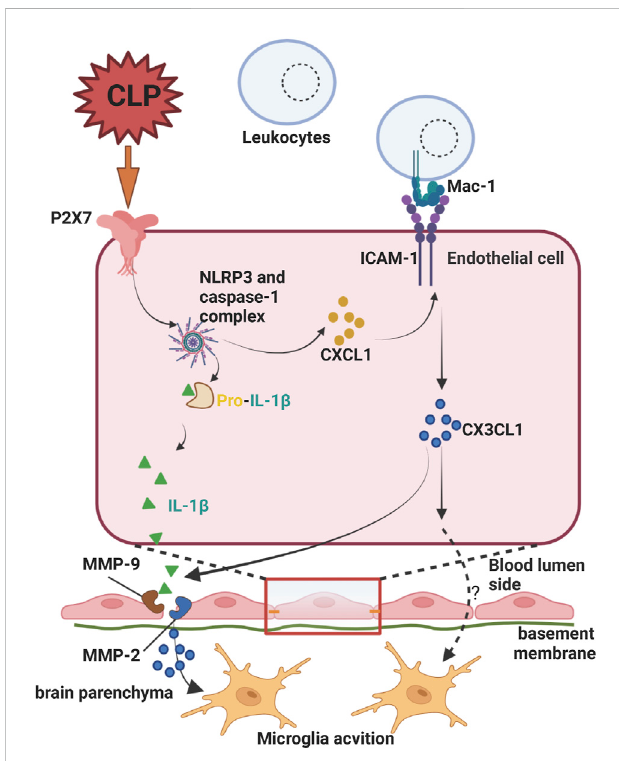
FIGURE 3 Endothelial P2X7 signaling on the permeability of the blood-brain barrier in septic encephalopathy (SE). Increased P2X7 receptor signaling in brain microvascular endothelial cells of SE mice generated by cecal ligation and puncture (CLP) increased adherence of Mac-1 expressing leukocytes to endothelial cells intercellular cell adhesion molecule-1(ICAM-1) and upregulated endothelial cell chemokine (C-X3-C motif) ligand 1 (CX3CL1), which activated microglia. The uncertainty exists as to whether CX3CL1 directly alters blood-brain barrier integrity during this process. P2X7 receptor signaling also promoted BBB breakdown and neurovascular injury during SE by activating NLRP3/caspase-1/IL-1 β signaling. Created with